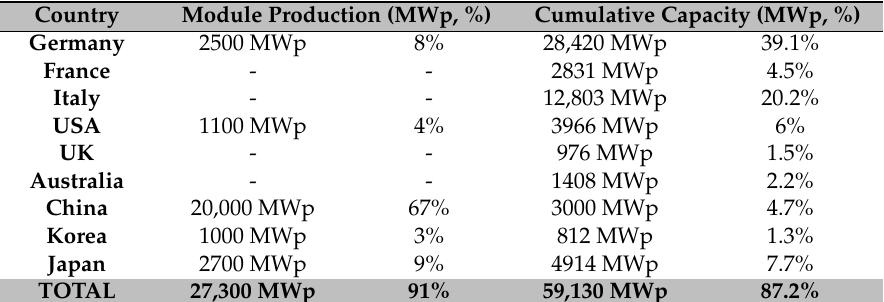
Table 1. Module Production, Cumulative Capacity and Market Share Totals for end 2011.